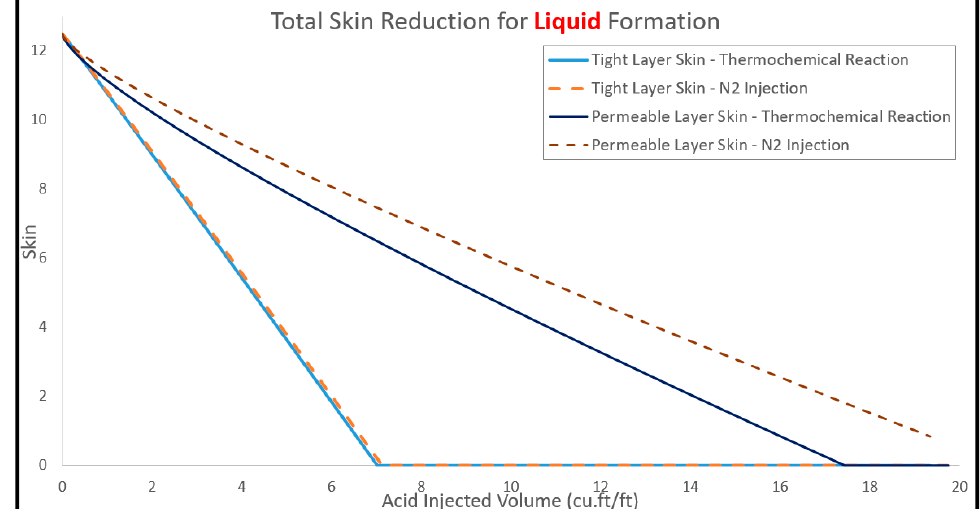
Figure 13. The skin behavior during acidizing and diversion process using thermochemical reaction and N 2 injection.